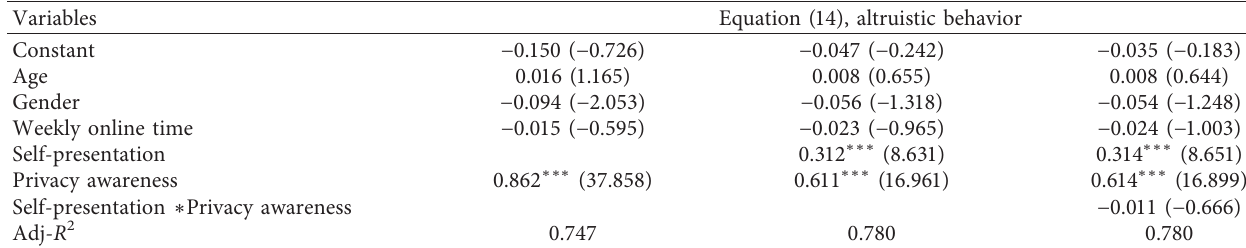
Table 5: Regression results of moderating effect of privacy awareness.